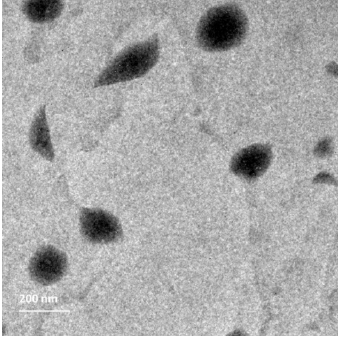
Figure 5. Transmission electron microscopy micrograph of the optimized BER-CTS-BLS formulation.